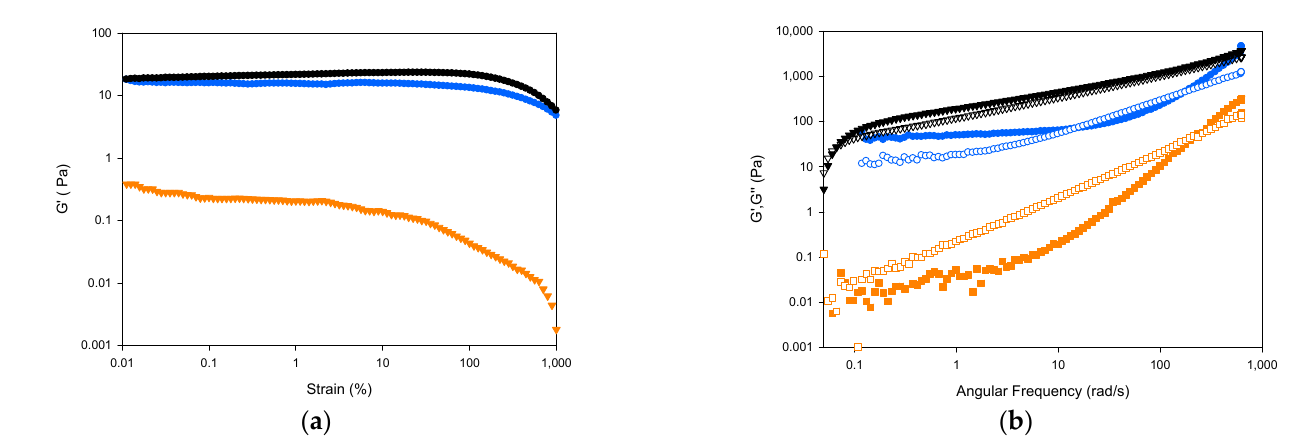
Figure 6. Strain and frequency sweeps for solutions of seabass, trout and seabream gelatins (30% wt in water). Store (G ′ ); (filled symbols) and loss moduli (G ″ ); (hollow symbols) depicted versus strain ( a ) and angular frequency ( b ). ( blue circles ) seabass, ( ochre circles ) trout and ( black circles ) seabream gelatin hydrogels at 20 °C.